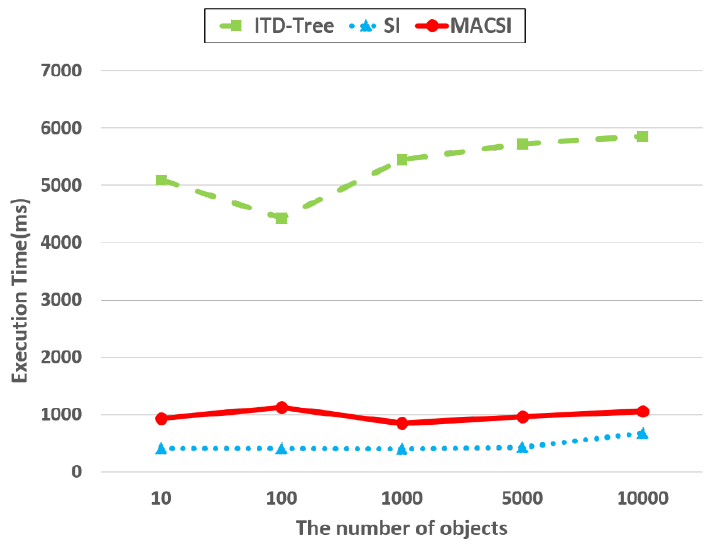
Figure 21. The effect of object number on the coarse-grained semantic cell query performance.